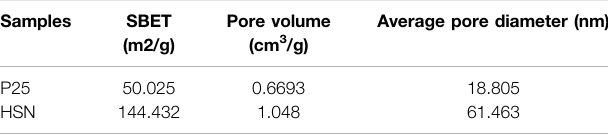
TABLE 1 | Physical parameters of TiO 2 HSN and P25 fi lms with N 2 adsorption tester. Samples SBET (m2/g)